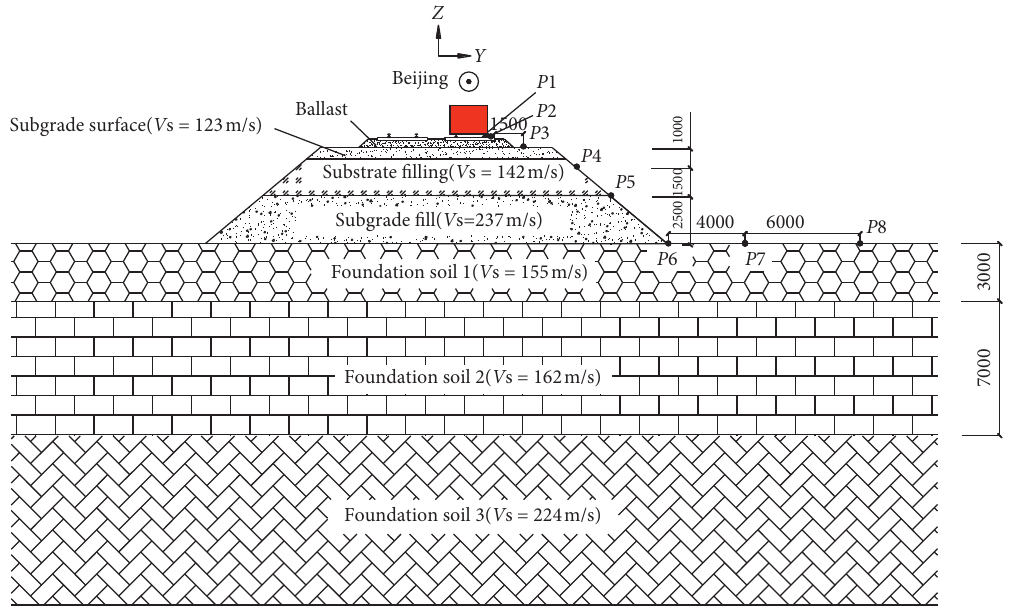
Figure 1: Layout of measuring points for the cross section of the monitoring